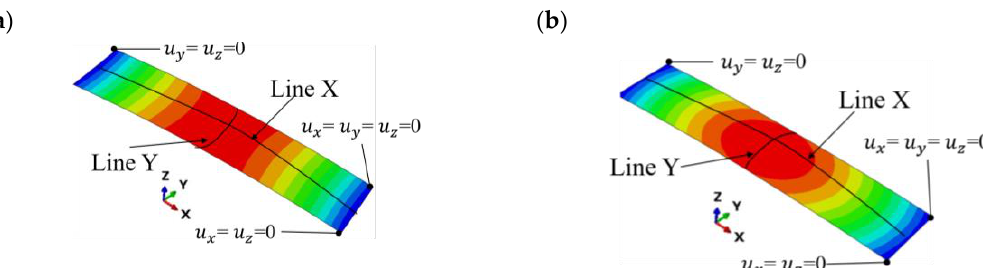
Figure 21. ( a ) Saddle shape by induced stress σ xx . ( b ) Spherical shape by induced stress σ xx and σ yy